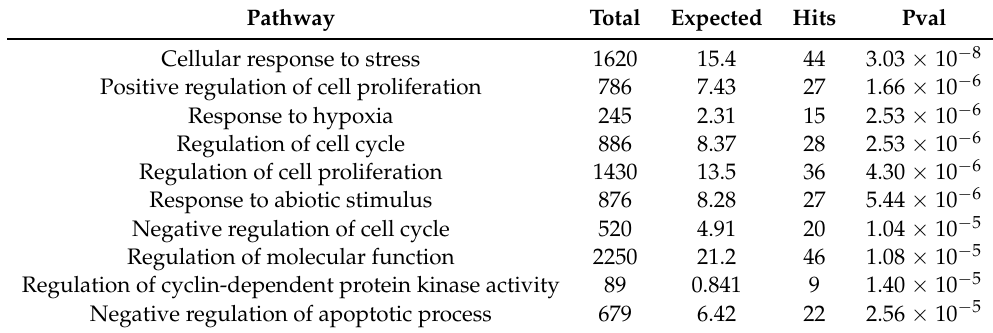
Table 7. Top 10 miRNet enrichment analyses in the Gene Ontology-Biological Process (GO:BP) dataset for miRNAs hsa-miR-122, hsa-let-7a, hsa-miR-23b, hsa-miR-708 and hsa-miR-200c.